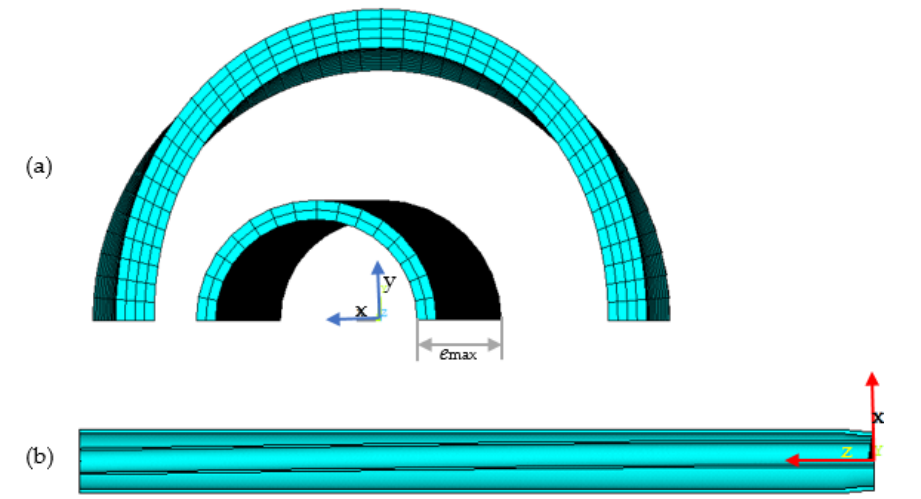
Figure 10. Model and mesh of Case N40.03: ( a ) back view and ( b ) bottom view. Table 5. The initial imperfection of the inner